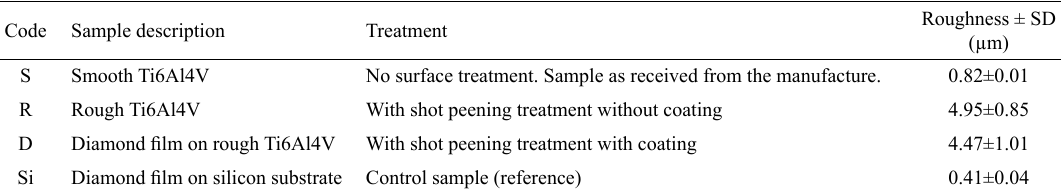
Table 1. Code description, treatment/deposition and roughness of the surface. Code Sample